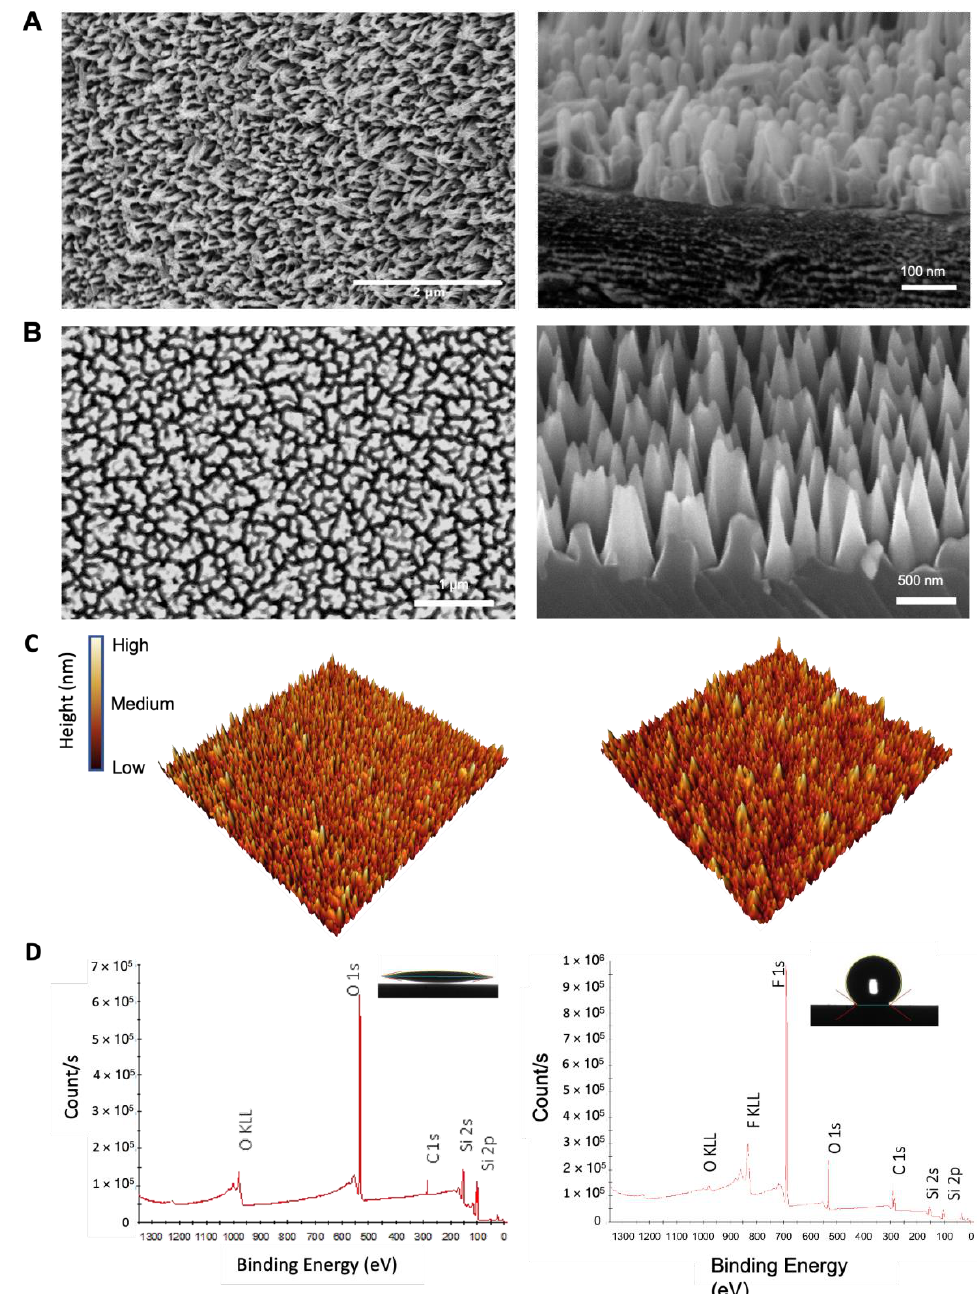
Figure 1. Surface topographic analysis of nSi-H and nSi surfaces, which were synthesised to mimic the nanotopography of damselfly wings. ( A ) The representative image of a damselfly wing and representative SEM micrographs of nanopillars on damselfly wings, included for comparison. Drag- onfly wing nanopillars are approximately 250 nm in height with interpillar spacing of 200 nm. ( B ) Representative SEM micrograph of nano-Si surfaces, including top-view and titled micrographs. Pillars were recorded to have a height of 796 ± 96 nm, and a tip-tip separation of 182 nm. ( C ) Corre- sponding 3D visualisation of AFM micrographs of the surface topography of nSi and nSi-H. ( D ) XPS survey scan results for surface chemical composition and wettability of nSi (left) and nSi-H (right).